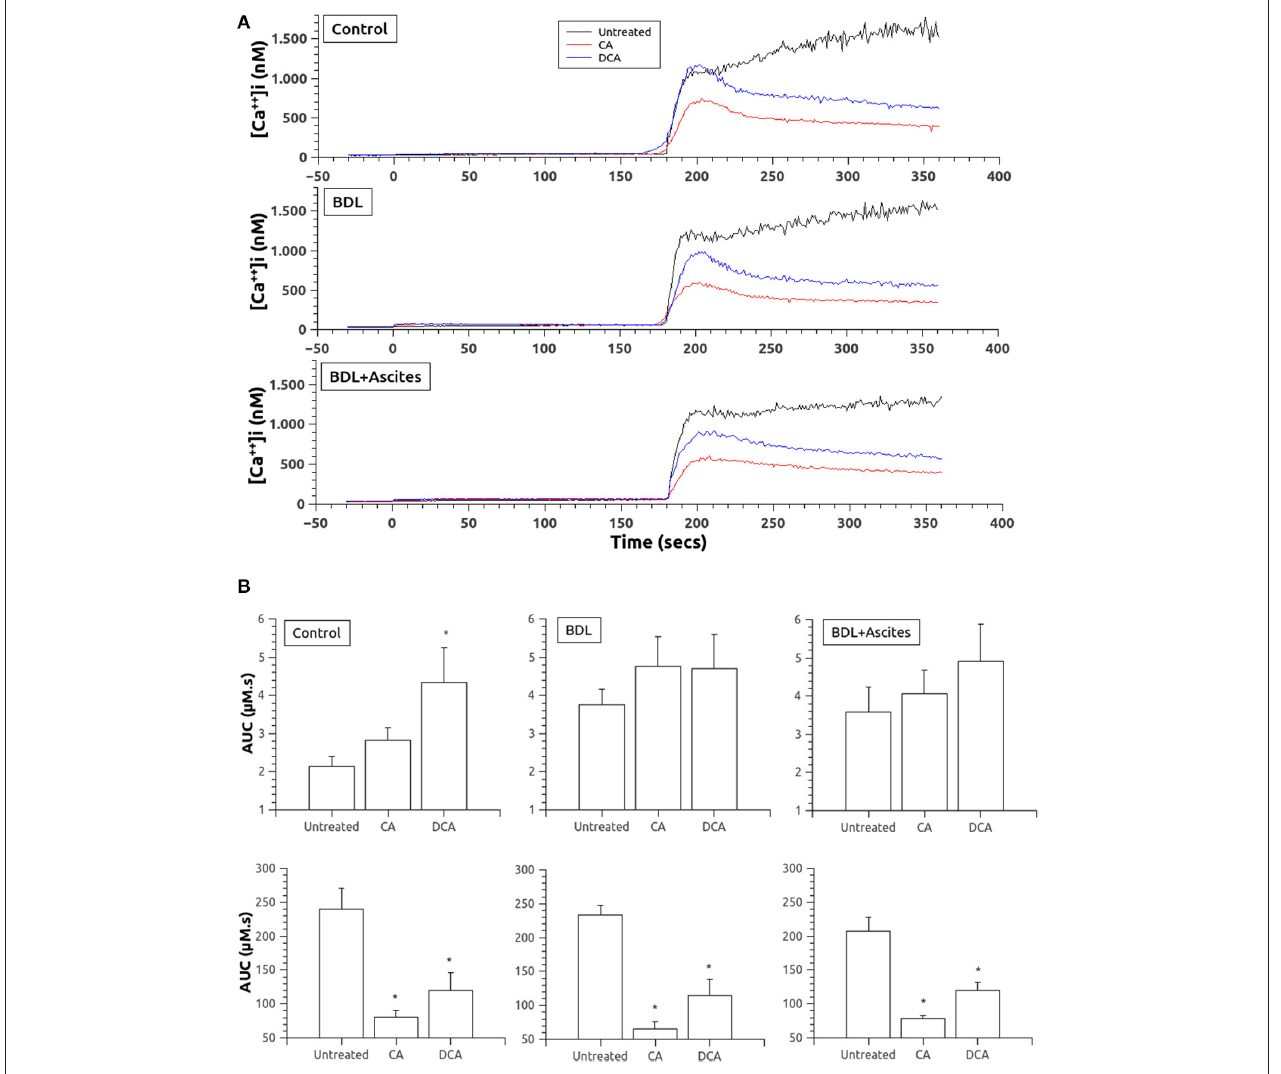
FIGURE 2 | (A) Changes in [Ca 2 + ] i after thapsigargin administration in the absence of extracellular Ca 2 + (time 0 seconds) and after addition of calcium to allow for capacitative Ca 2 + entry (time 180 s). Data were obtained in untreated platelets and after incubation with CA or DCA (100 µ M). (B) Area under the curve of the calcium changes after thapsigargin administration in the absence of extracellular Ca 2 + (top panels) and after addition of calcium to allow for capacitative Ca 2 + entry (bottom panels). Data were obtained in untreated platelets and after incubation with CA or DCA (100 µ M). Results are means ± S.E.M. * p < 0.05 vs.